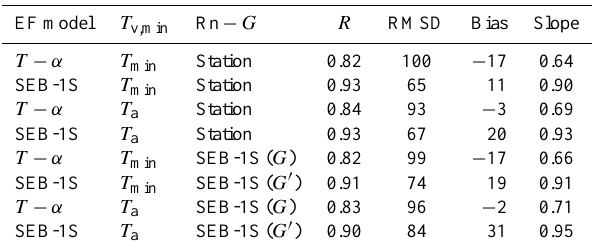
Fig. 6. Modeled net radiation (a) , ground heat flux using 0 formu- lation (b) , ground heat flux using 0 0 formulation and T v,min = T min assumption (c) , and ground heat flux using 0 0 formulation and T v,min = T a assumption (d) versus station measurements. Table 3. Correlation coefficient, root mean square difference, mean bias and slope of the linear regression between simulated and ob- served ET.